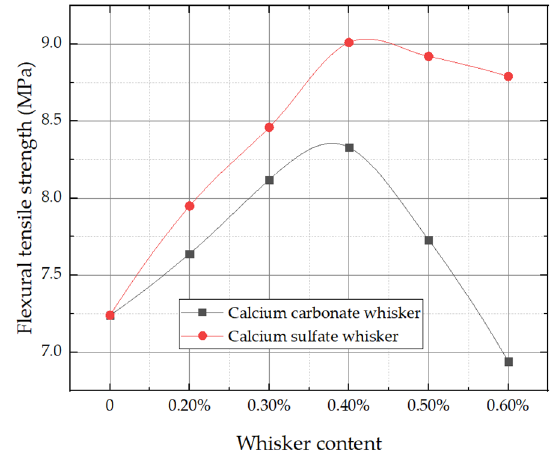
Figure 4. Flexural tensile strength test results.